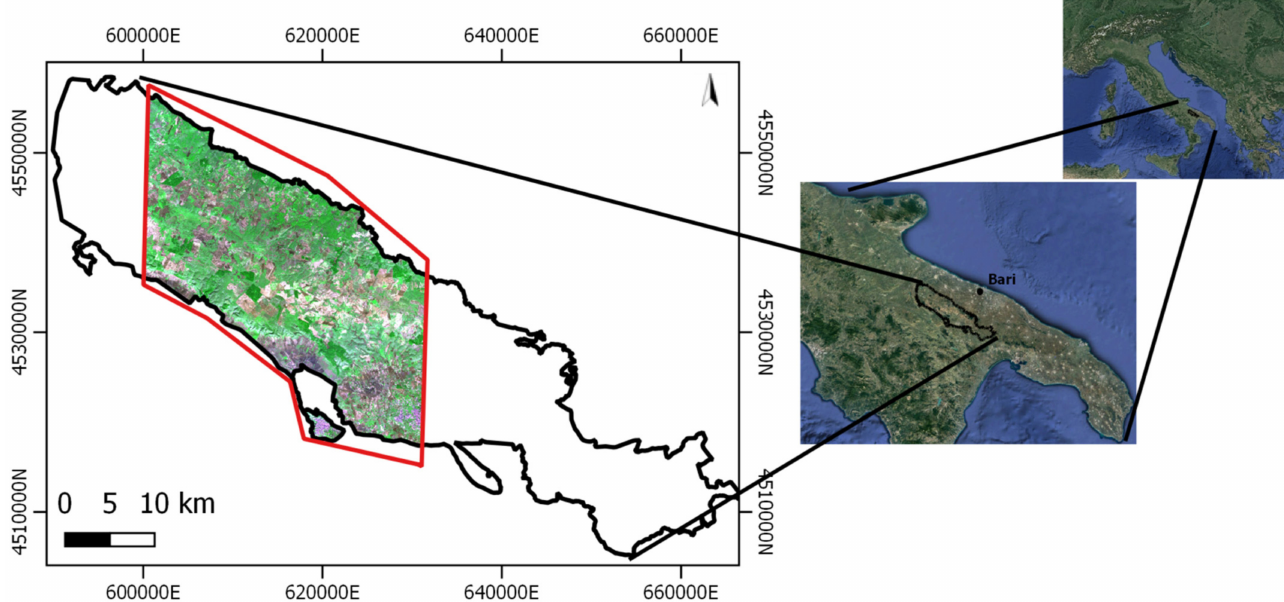
Figure 1. On the left, Sentinel-2 image, 10 m spatial resolution, acquired on 27 October 2018. “Murgia Alta” protected area and study area in black and red boundaries, respectively. On the right, location of study site within an enlarged geographical